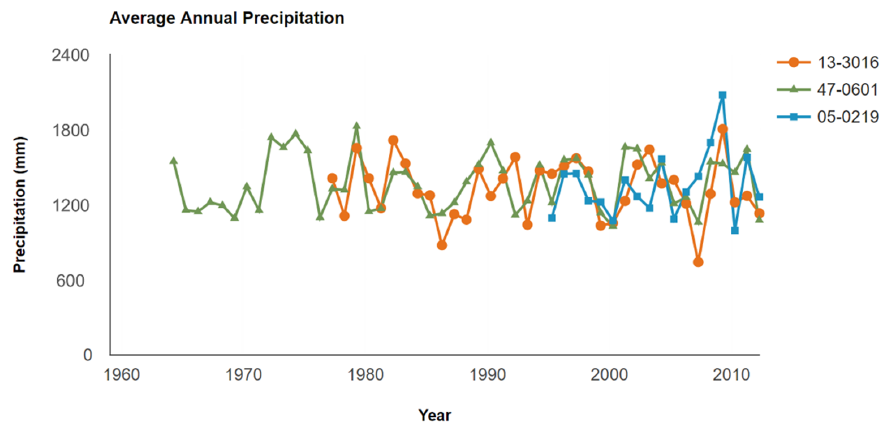
Figure 3. The change in precipitation in different sections.